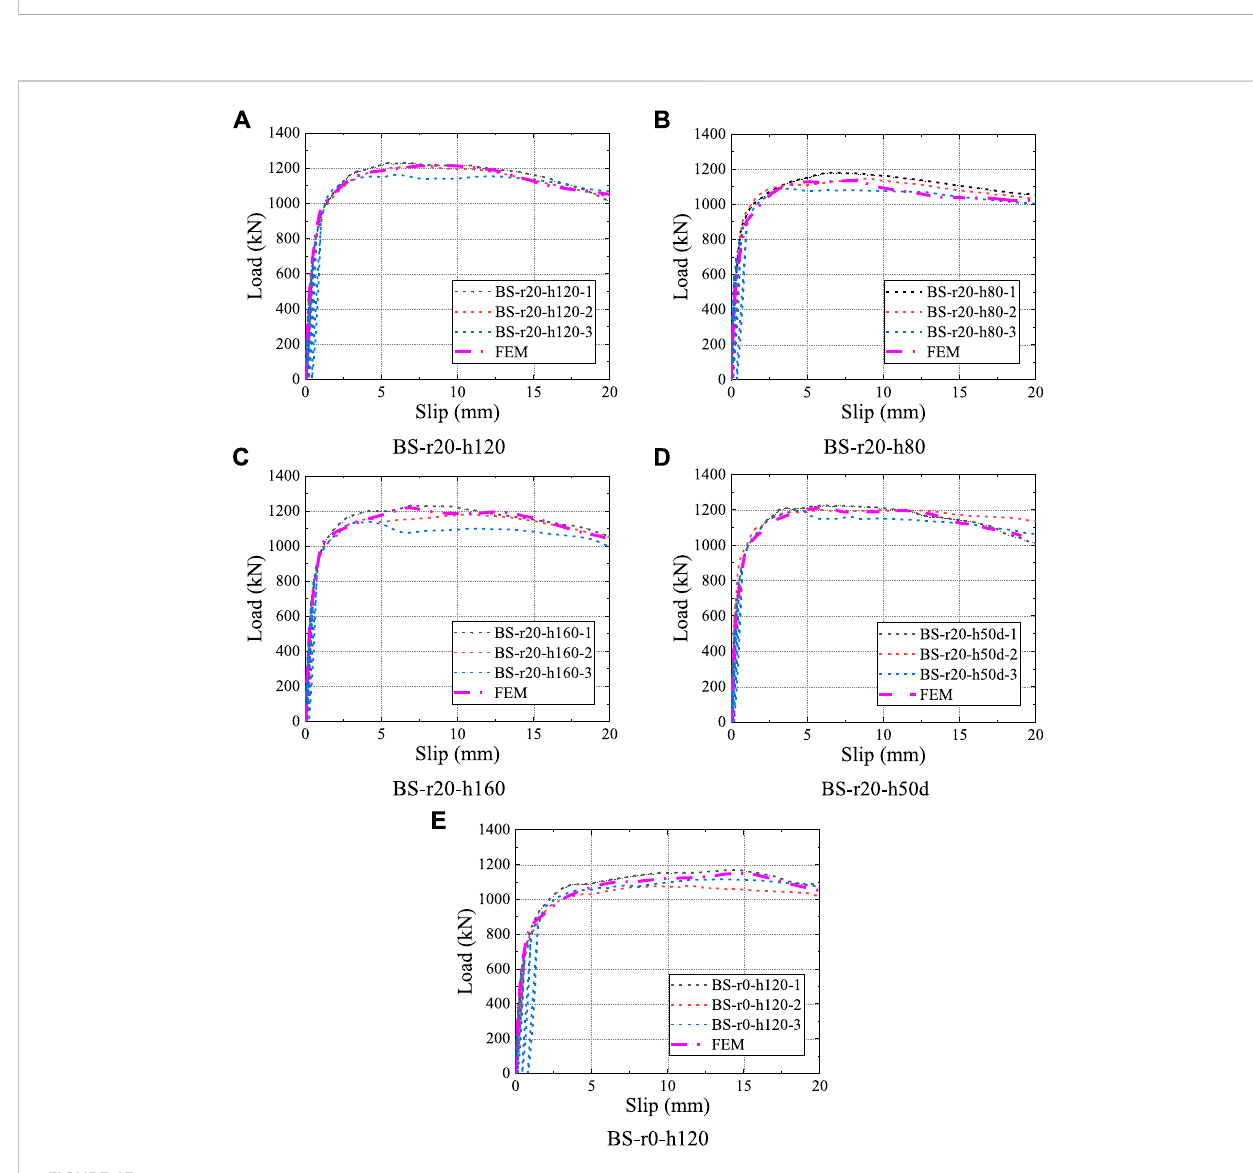
Comparison of the load-slip curves. (A) BS-r20-h120 (B) BS-r20-h80 (C) BS-r20-h160 (D) BS-r20-h50d (E)